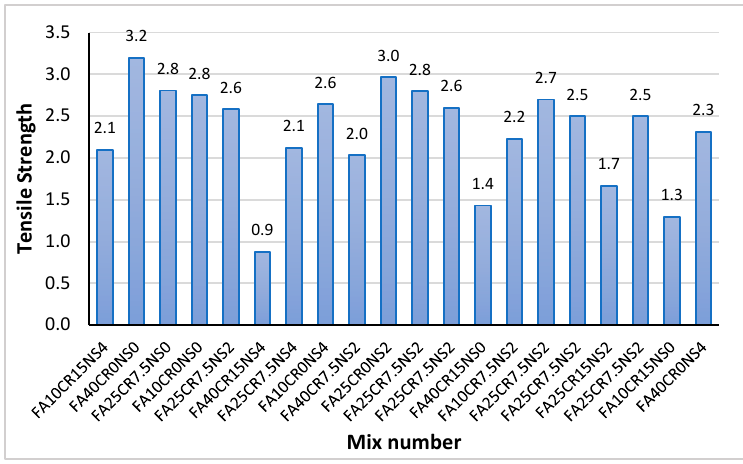
Figure 10. Tensile strength of RSCC mixes at 28 days.